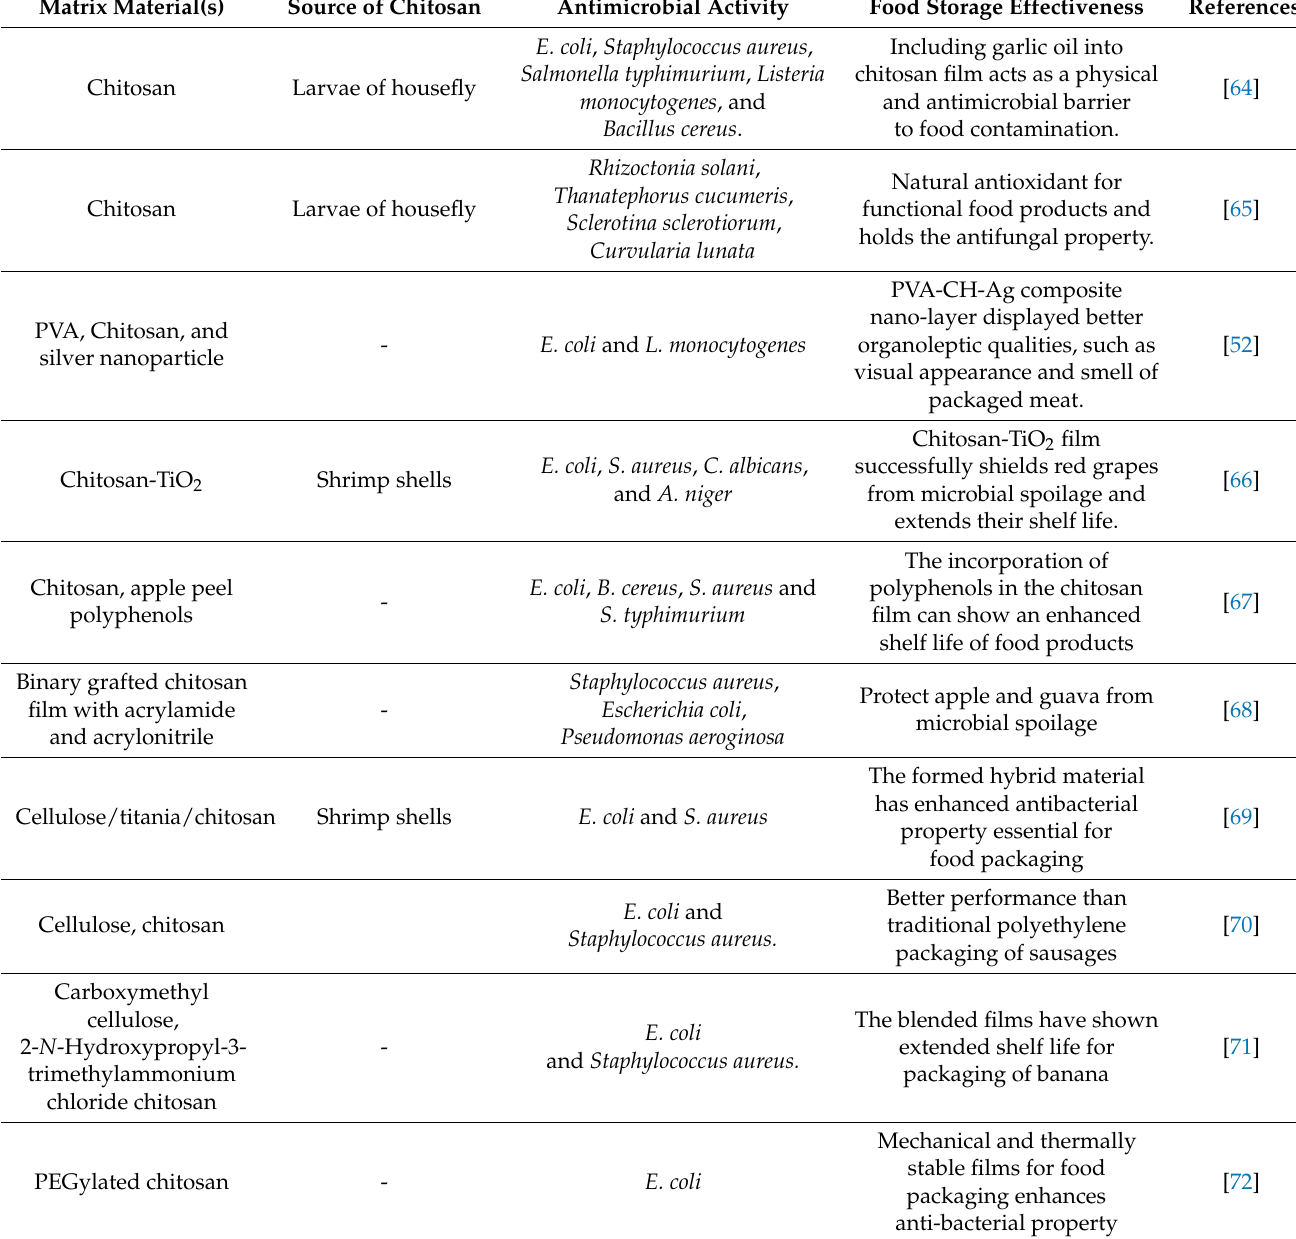
Table 1. Uses of chitosan (source)/derivatives for the specific antimicrobial activity or food storage effectiveness. Matrix